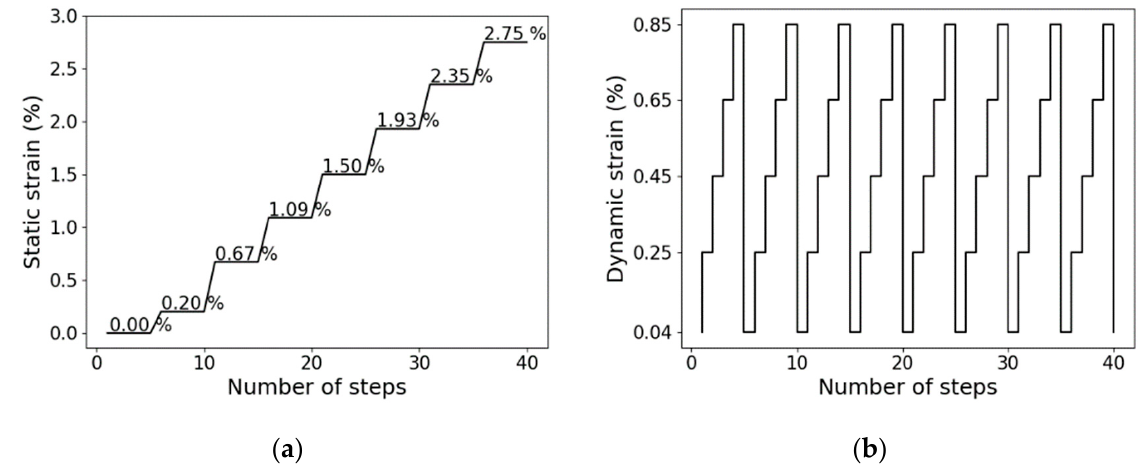
Figure 4. ( a ) Static and ( b ) dynamic tests procedure to investigate the MR effect of SEBS-based composites.